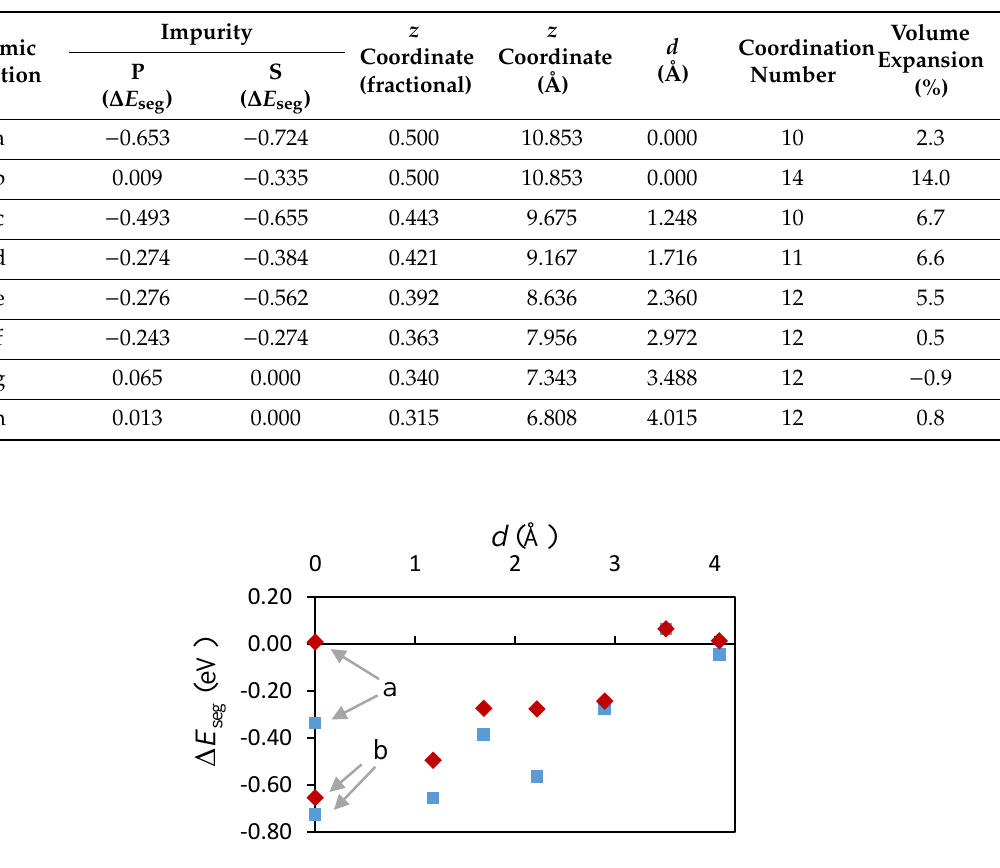
Figure 2. Segregation energies Δ E seg (eV) for P and S to the Σ9 GB as a function of distance from the GB center ( d ) (Å ). S ( ■ ), P ( ♦ ). The labels a and b represent the data points for sites a and b.